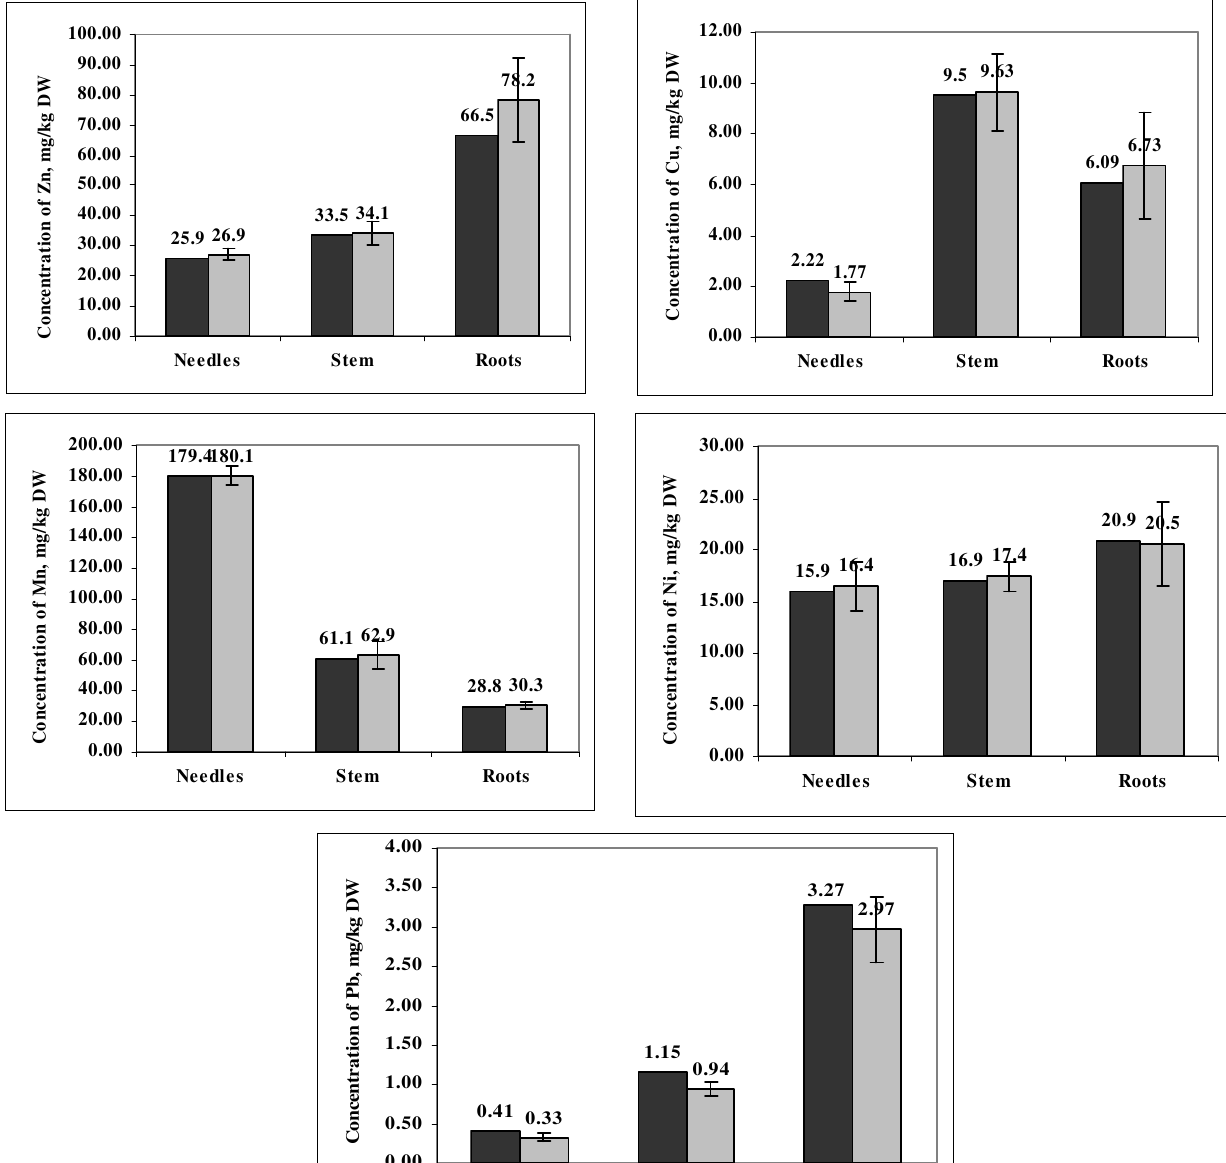
Fig 2 . Concentration of TMs in three compartments of a coniferous tree (pine): simulation results are presented in black, and experimental results – in grey (the bars denote ± SE, n =